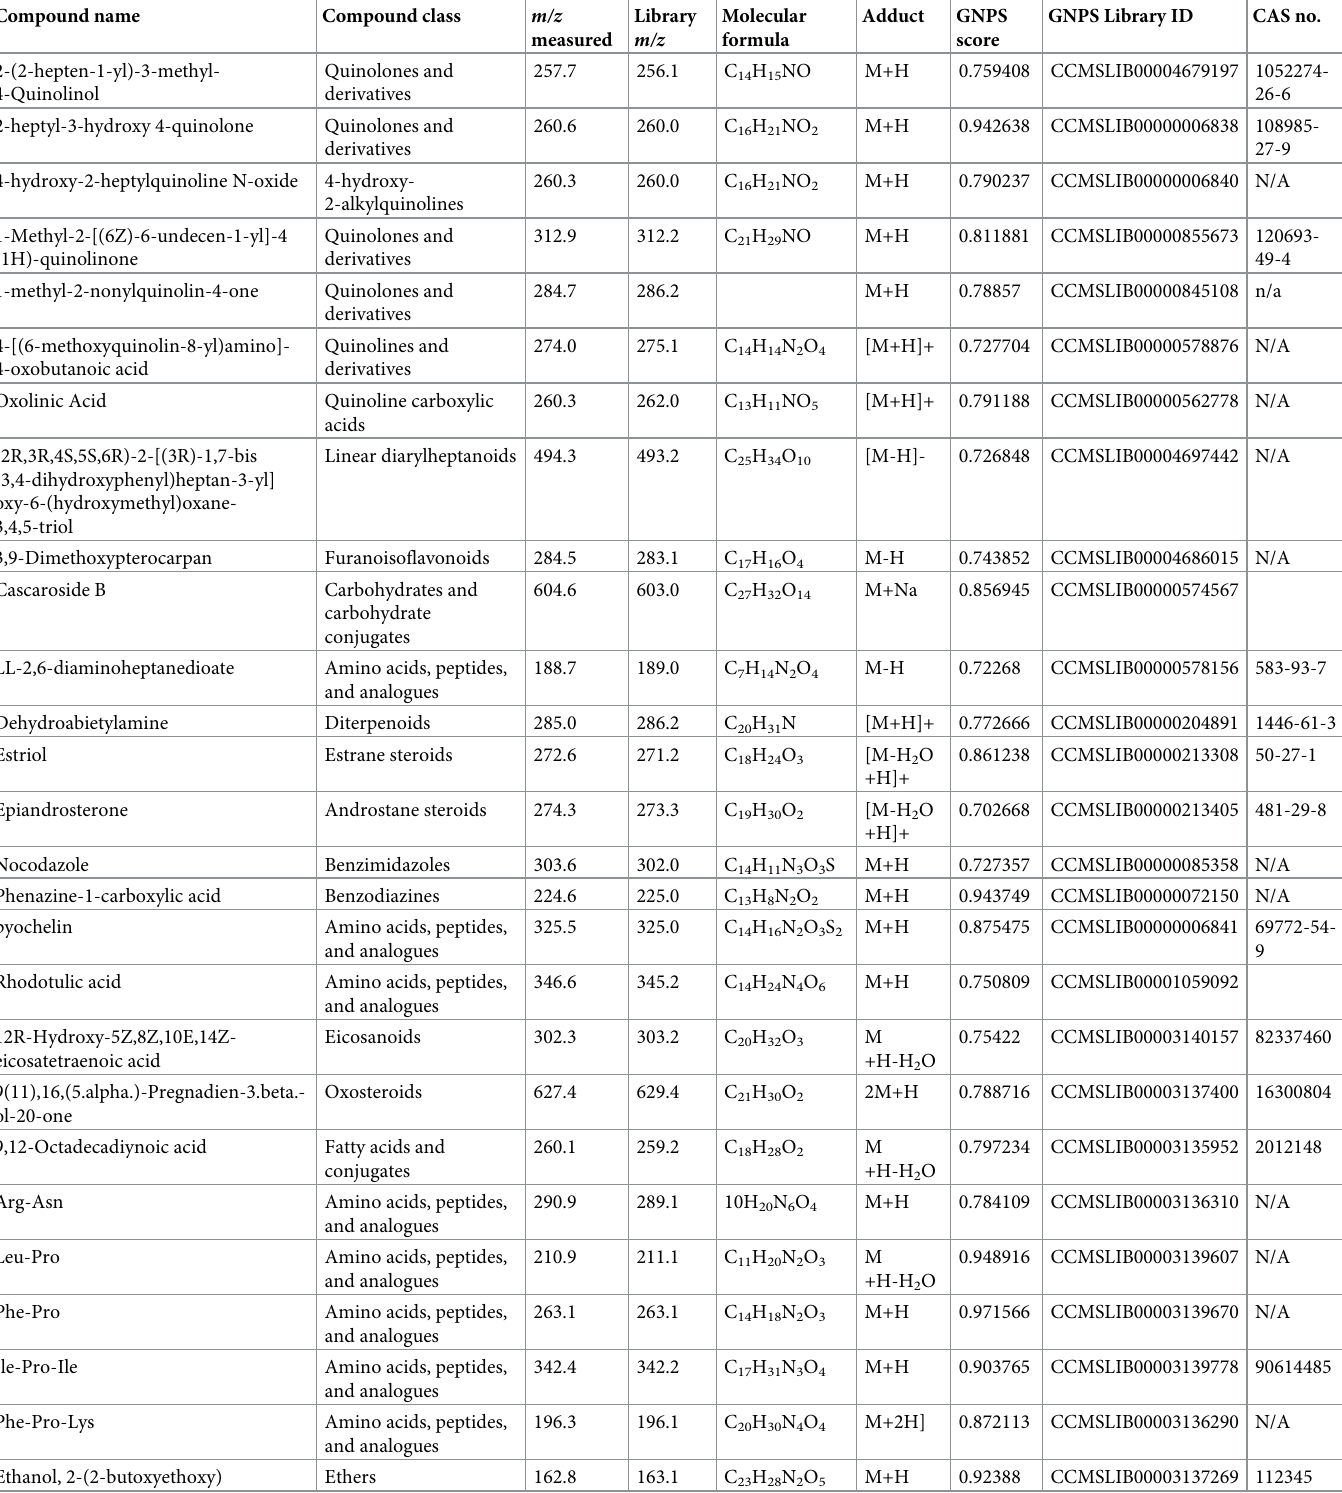
Table 1. Putative identification of secondary metabolites and compounds in the ethyl acetate fraction of P . aeruginosa